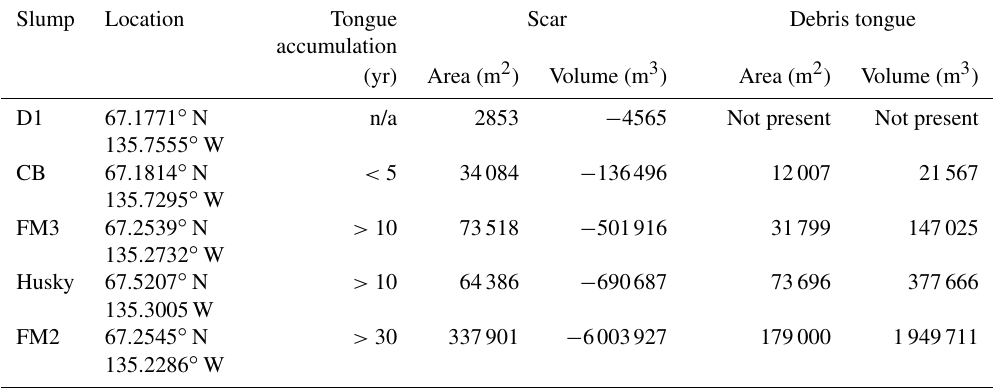
Table 1. Scar and debris tongue areas and volumes (sediment erosion and thaw subsidence vs. deposition) as well as debris tongue age for a retrogressive thaw slump size–age continuum from September 2018 field observations. Slump Location Tongue Scar Debris tongue accumulation (yr) Area (m 2